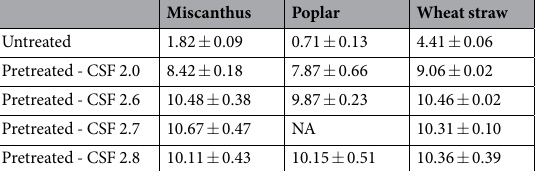
statistical analysis of the weight of different structural factors controlling hydrolysability of pretreated biomasses showed that many factors were involved and not a single one could explain saccharification 19–21 . Moreover, meas- uring parameters such as lignin content, cellulose crystallinity or porosity (for example through Simons’s staining or thermoporosimetry) is not straightforward nor rapid. Spectral parameters from infra-red spectroscopy data relative importance of chemical and structural factors depends on biomass species, pretreatment type and process conditions, no general factor has been revealed until now 24 .